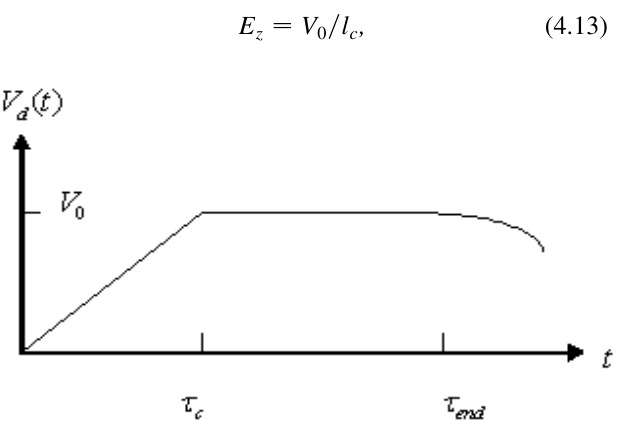
FIG. 15. Drive voltage waveform applied at the input of the helix in the snowplow mode. The ion bunch is loaded prior to t (cid:3) 0 .